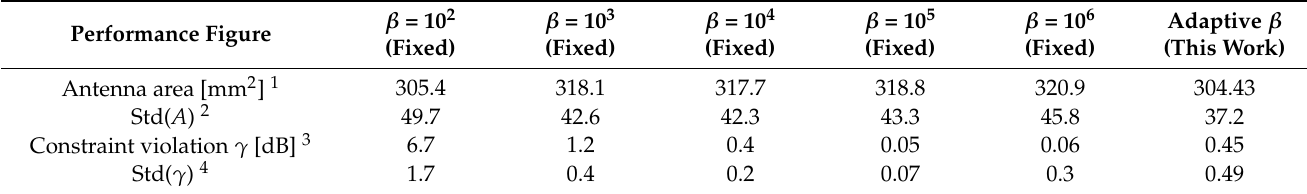
Table 3. Optimization results for antenna